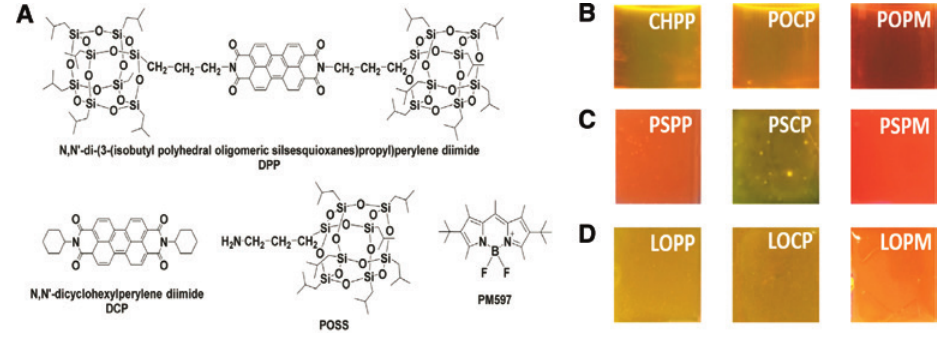
Figure 1: Materials structures and samples information. The molecular structures of the DPP, DCP, POSS and PM597 (A). The solution samples pictures of CHPP, POCP and POPM (B); PSPP, PSCP and PSPM (C); LOPP, LOCP and LOPM